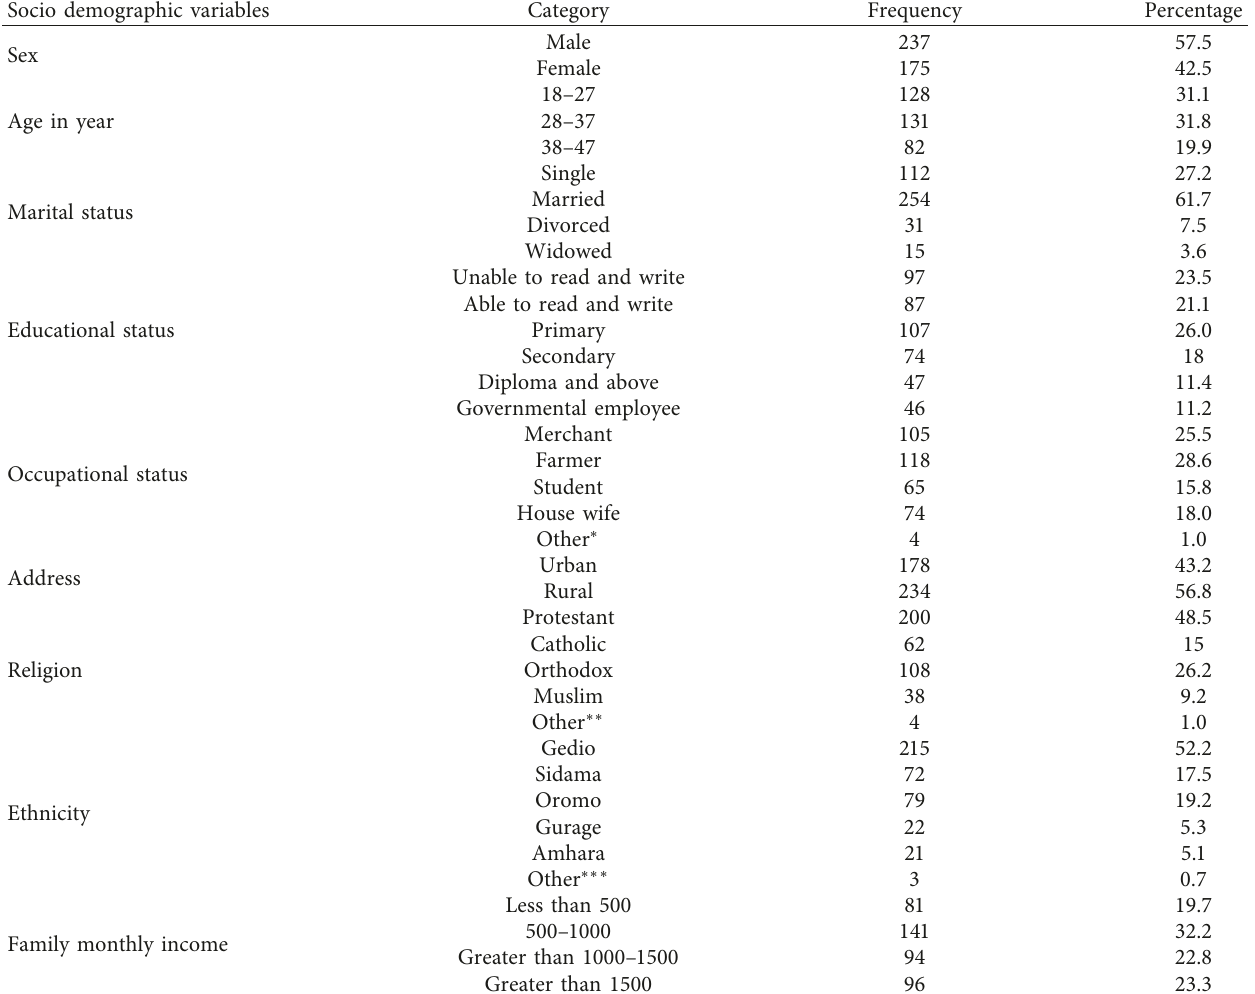
Table 1: Sociodemographic characteristics of clients in the outpatient department of DURH, SNNPR, Ethiopia, 2021 ( n � 412). Socio demographic